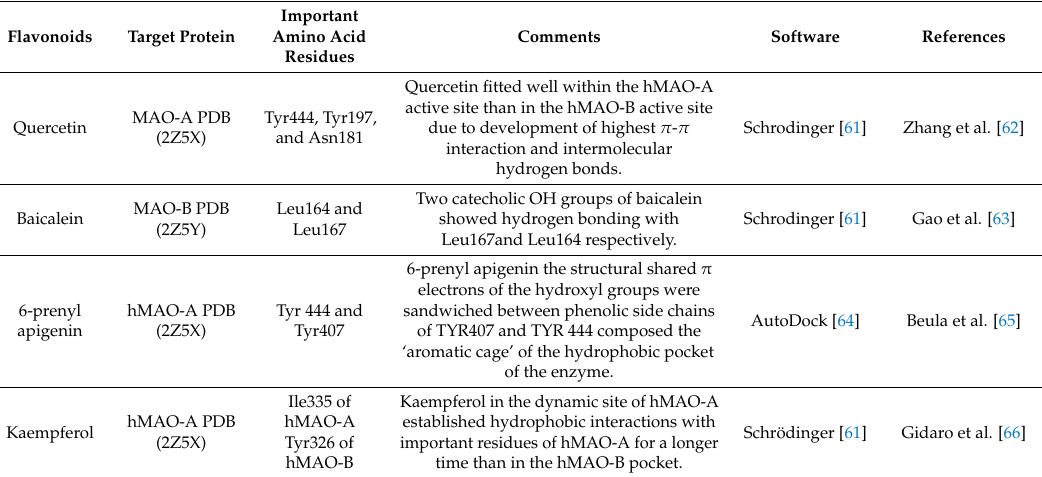
Table 1. Docking profile of natural flavonoids with target protein and